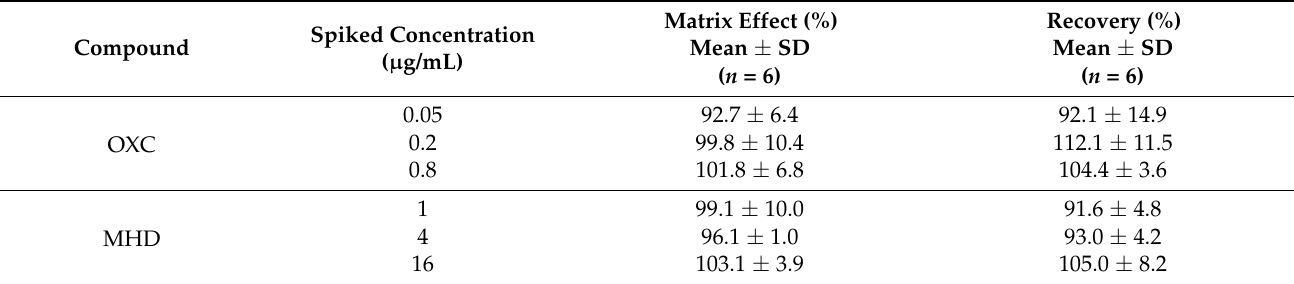
Table 2. Matrix effect and recovery of oxcarbazepine (OXC) and 10-hydroxycarbazepine (MHD) from LC-triple-stage fragmentation (MS 3 ) method.